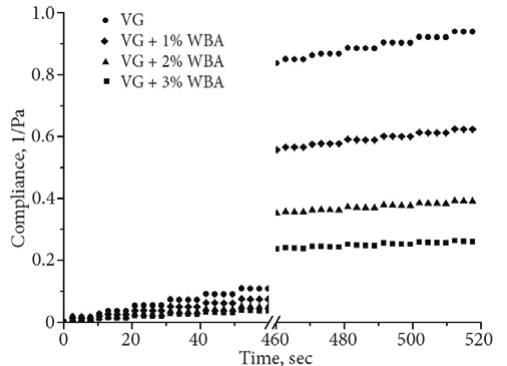
Figure 7. Results of repeated creep-recovery test performed